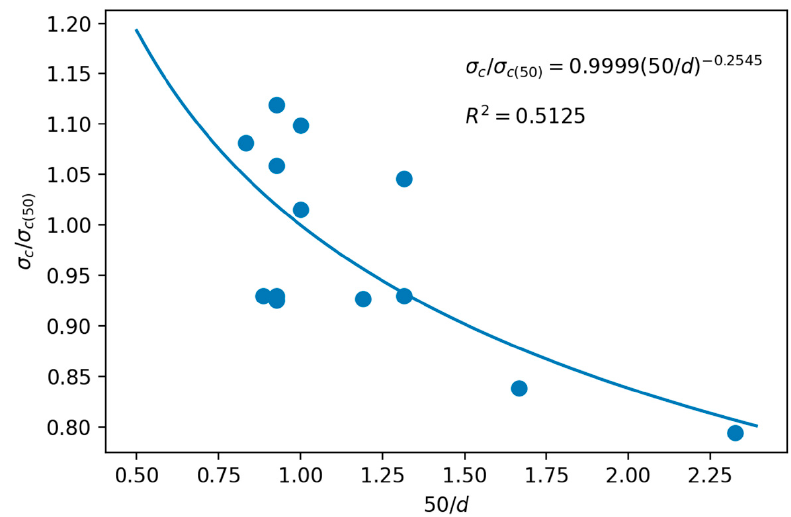
Figure 8. Scale effect curve from the estimated σ c of the limestone.